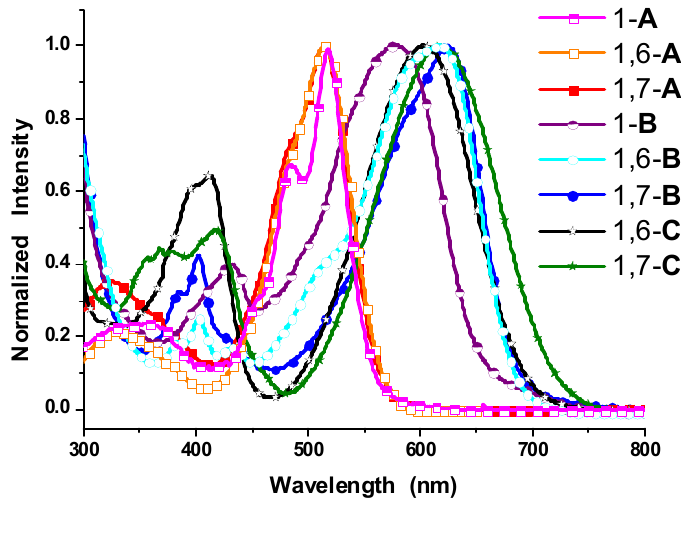
Figure 3. Normalized absorption spectra of 1- A , 1,6- A , 1,7- A , 1- B , 1,6- B , 1,7- B , 1,6- C , and 1,7- C in dichloromethane